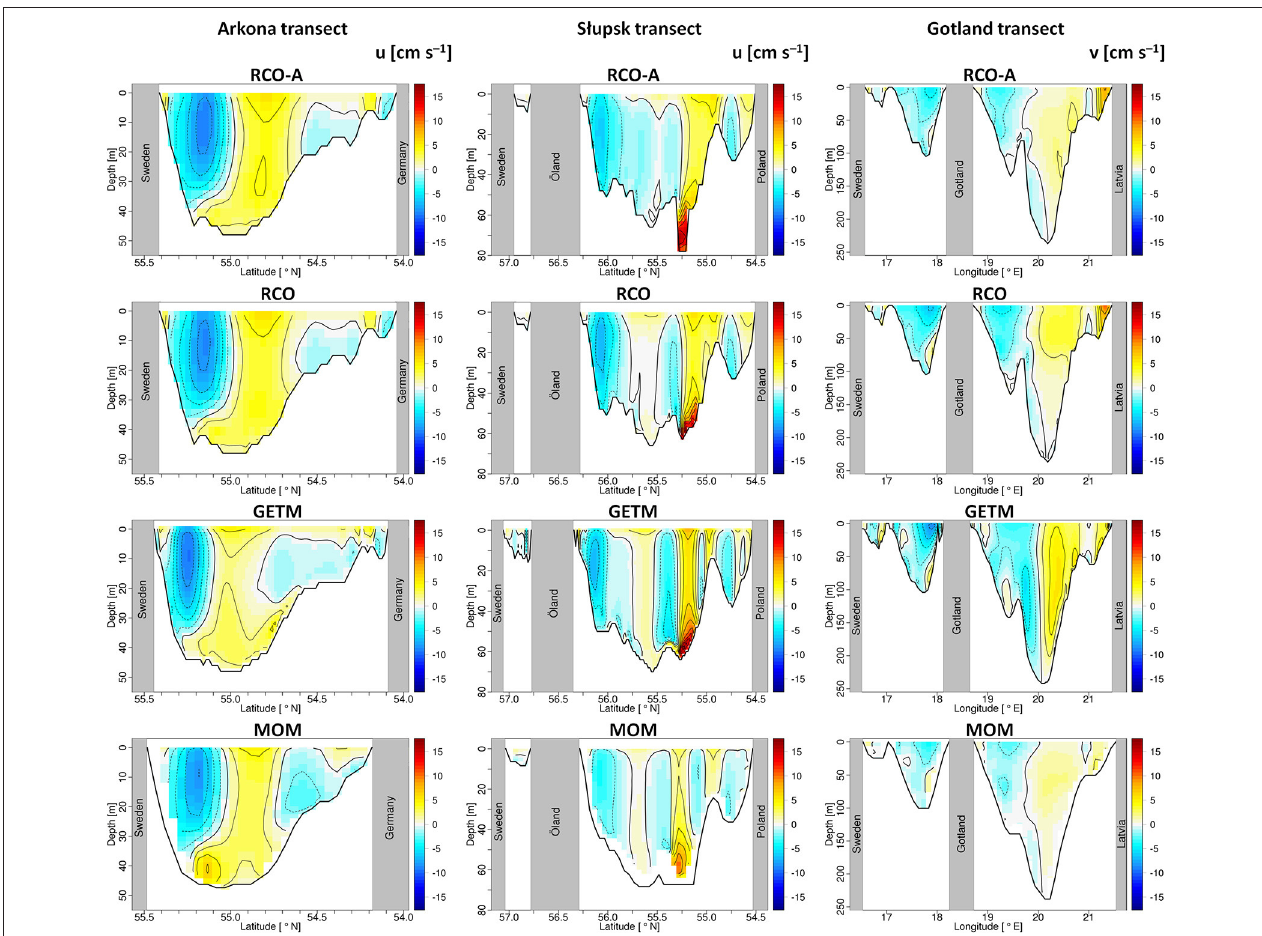
FIGURE 8 | Mean current velocities orthogonal through Arkona transect ( left ), Słupsk transect ( middle ), and Gotland transect ( right ) for the time period from 1970 to 1999 for the models RCO-A, RCO, GETM, and MOM. Positive values denote eastward velocity for Arkona and Słupsk transect and northward velocity for Gotland transect. Isolines are drawn every 2cm s − 1 (solid for positive values, dashed for negative values). Plotting range is ± 17.3cm s − 1 . Note, that the shown transects cover different depth ranges.